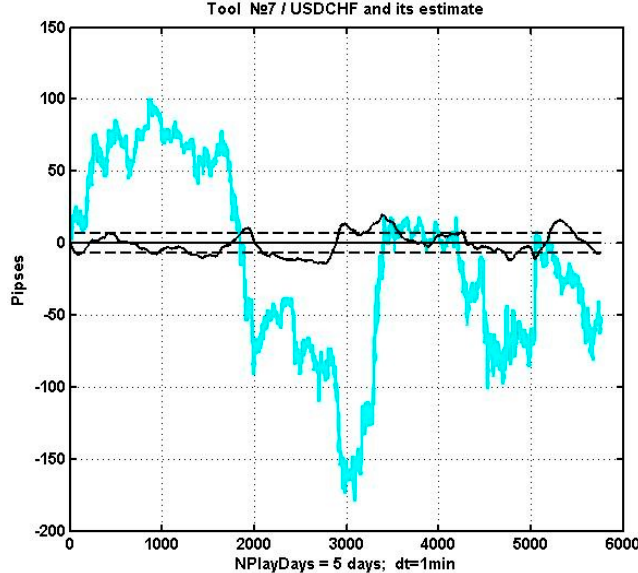
Figure 6. USDCHF price and the decision statistic.